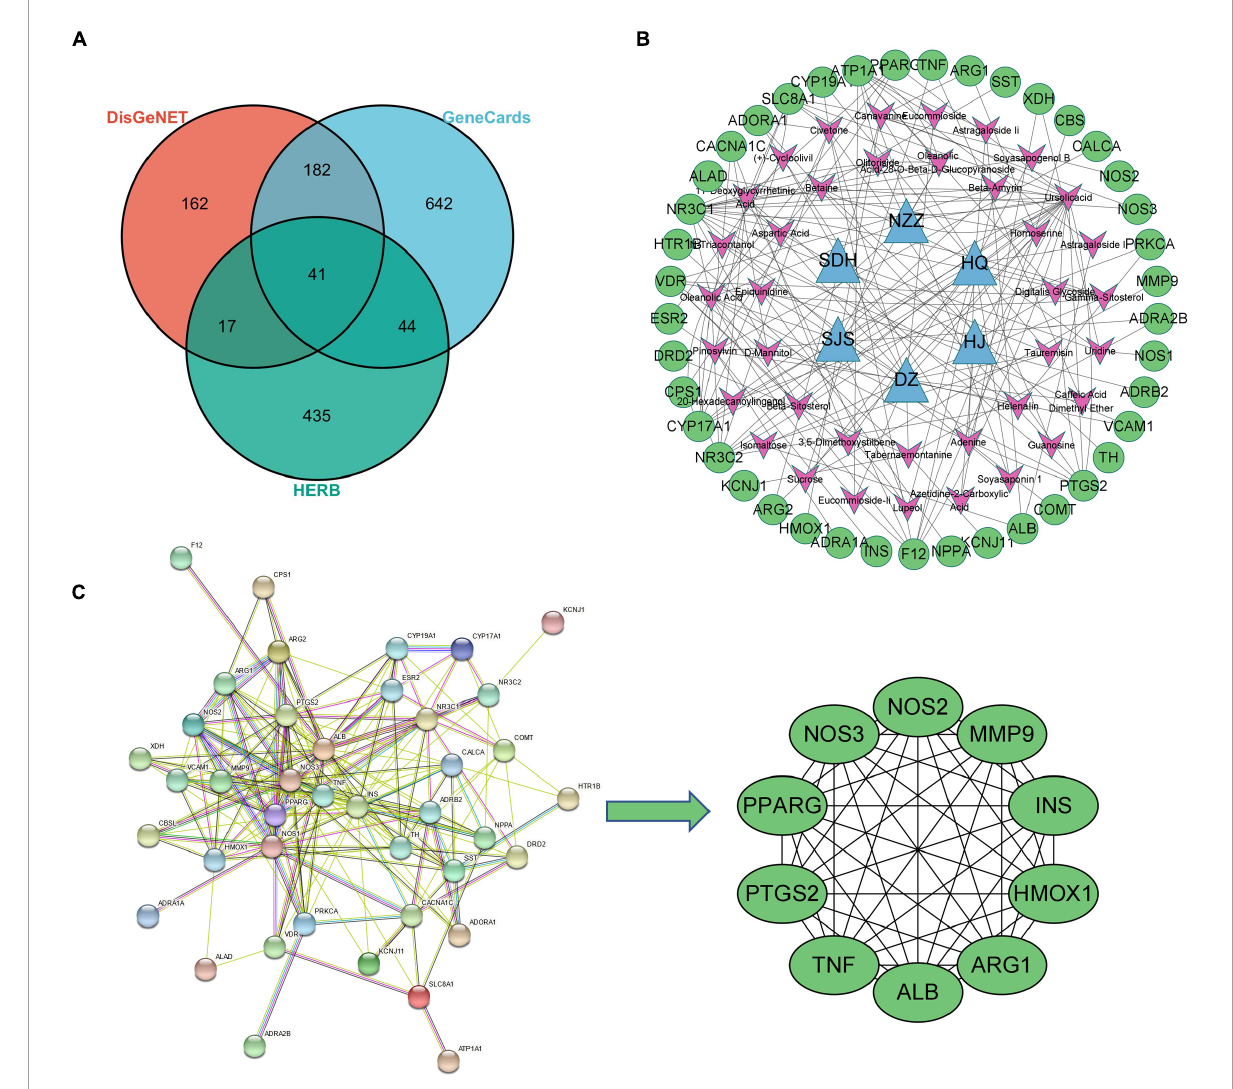
FIGURE10 Network pharmacological analysis. (A) VEEN of disease and herb targets; (B) compound-target network; (C) screening of PPI key